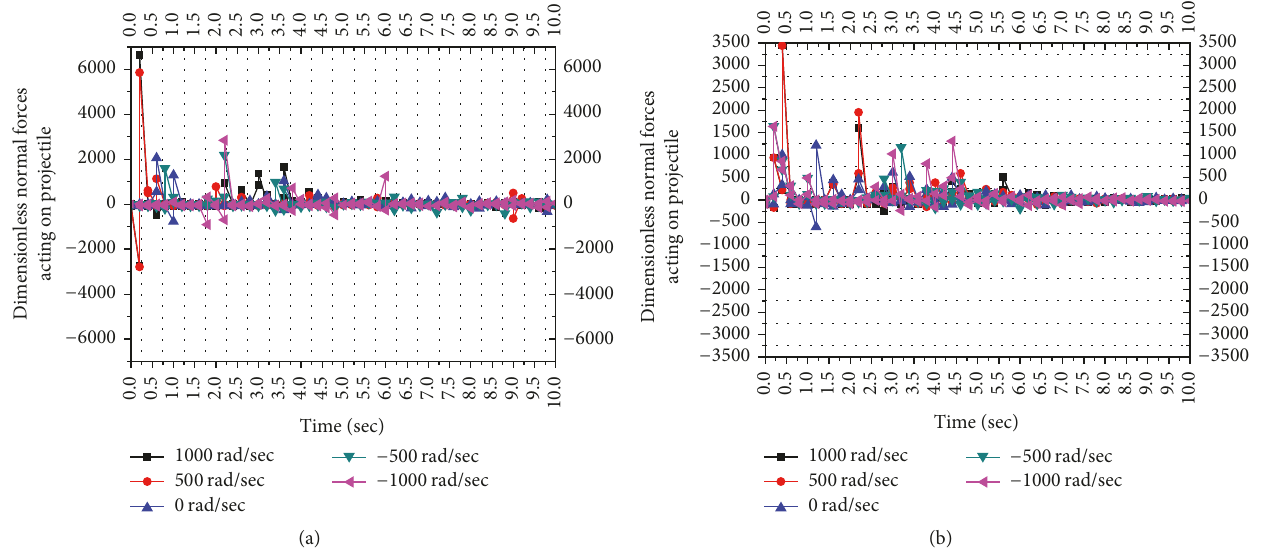
Figure 3: Normal forces acting on the projectile during penetration process. (a) Multisized particle bed. (b) Monosized particle bed.